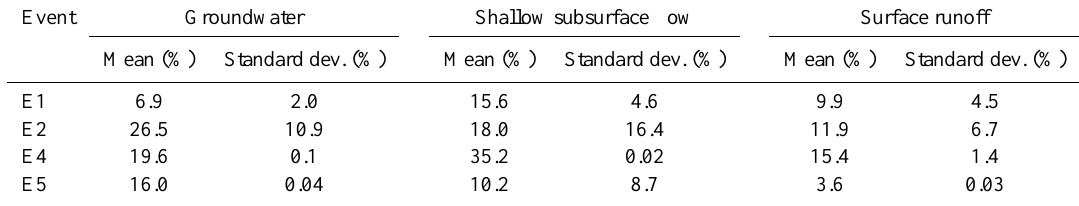
Table 4. Mean and standard deviation of the relative uncertainty of the separated components during E1, E2, E4, and E5.